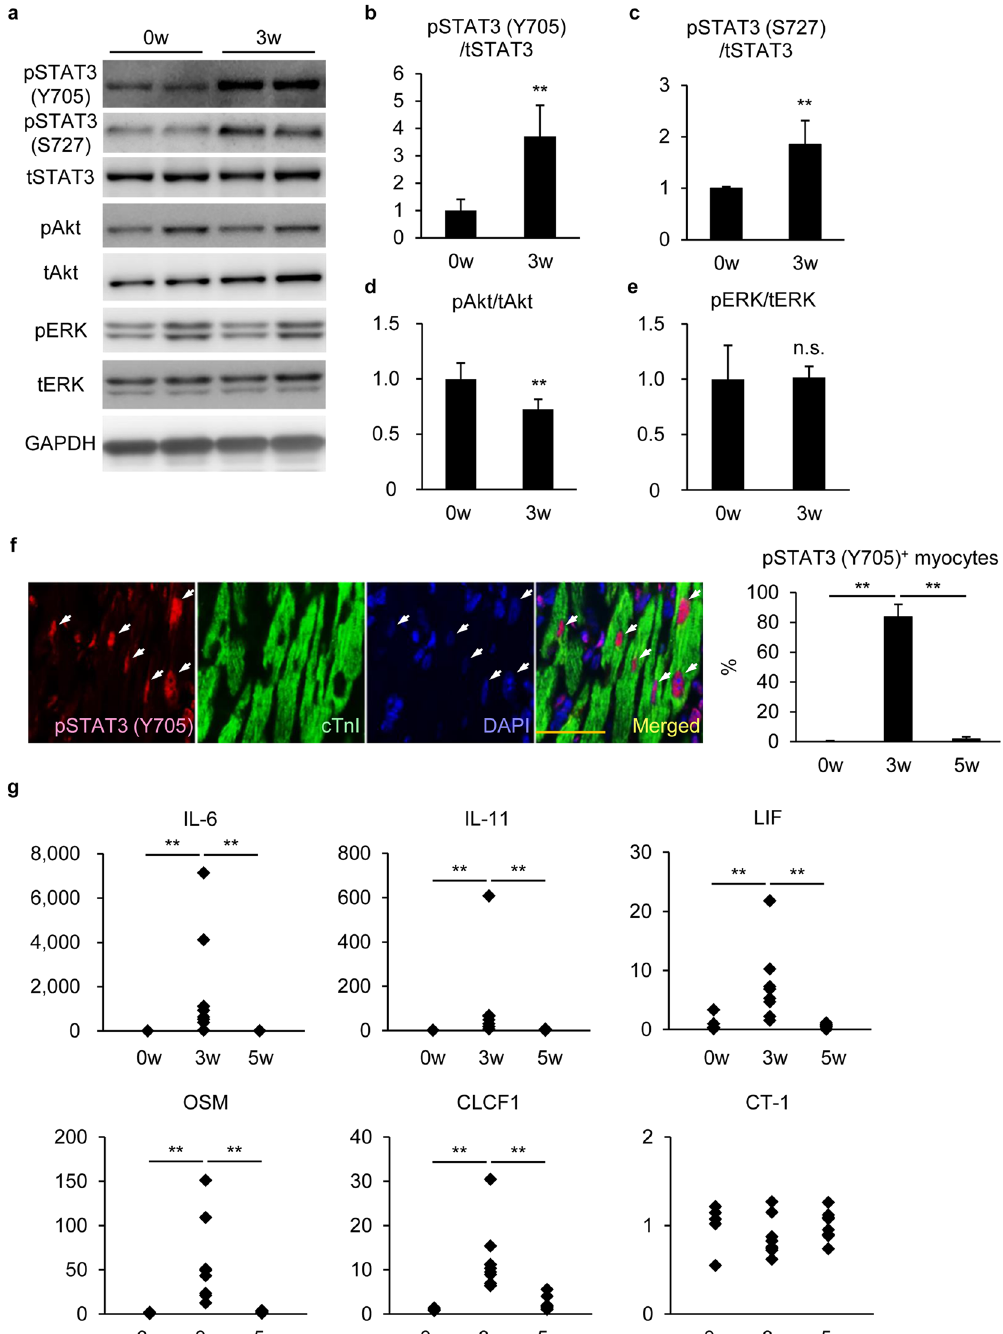
Figure 4. STAT3 was activated in cardiomyocytes at EAM3w. ( a ) Heart homogenates at EAM0w and EAM3w were subjected to immunoblotting with anti-phosphorylated STAT3 (pSTAT3) (Y705), anti-pSTAT3 (S727), anti-pAkt, anti-pERK and anti-GAPDH antibodies. Blots were reprobed with anti-total STAT3 (tSTAT3), anti- tAkt and anti-tERK antibodies. The full-length blots are presented in Supplementary Figure S3. ( b – e ) The band intensity was measured with ImageJ and normalized to that of GAPDH. Data are shown as fold increase relative to 0w. n = 4 mice for 0w; 6 mice for 3w. ( f ) Heart sections were immunostained with anti-pSTAT3 (Y705) and anti-cTnI antibodies at the indicated time points after EAM induction. Left: representative images of pSTAT3 (Y705) + cTnI + cells at EAM3w are shown. Arrows: pSTAT3 (Y705) + nuclei in cTnI + cells. Scale bar: 50 μ m. Right: pSTAT3 (Y705) + cTnI + cells in the inflamed region were counted and shown as percentage in cTnI + cells. n = 3 mice for each group. ( g ) The expression of IL-6, IL-11, LIF, OSM, CLCF1 and CT-1 transcripts was quantified at EAM0w and EAM3w by quantitative RT-PCR. The expression of these genes was normalized to that of gapdh and shown as fold increase relative to 0w. n = 5 mice for 0w; 8 mice for 3w and 5w. ( b – e ) Welch’s t -test; ( f ) Kruskal-Wallis test; ( g ) Steel-Dwass test. ** P < 0.01. Data are shown as mean ± s.d. in ( b – f